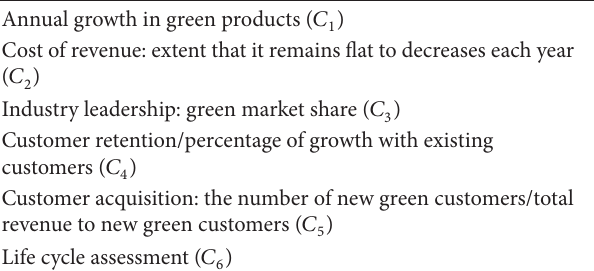
Table 3: Criteria for green supply chain.